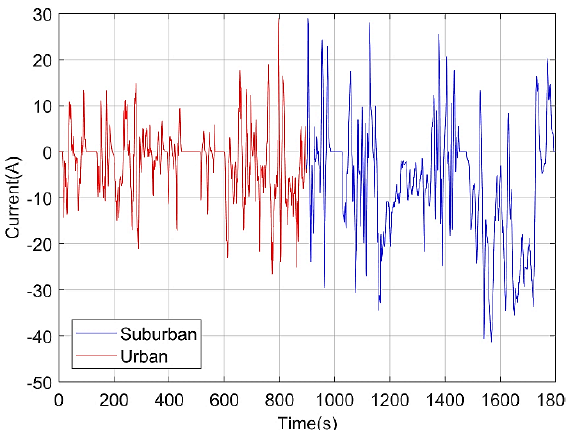
Figure 2. Illustration of worldwide harmonized light vehicles test (WLTC) current profile. The first part considered being demonstrative of urban driving conditions while the second part simulates driving conditions in the suburban. Each section takes 15 min.